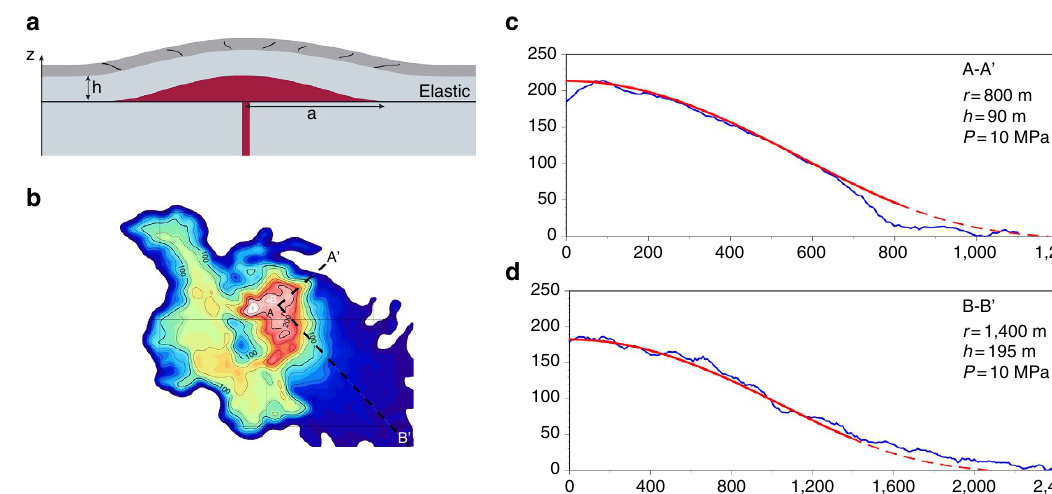
Figure 4 | Modeling deformation over a growing laccolith. ( a ) Model schematic showing a laccolith (red) and the overburden and wall rock in grey colours 23 . The overburden at Cordo ´ n Caulle is a mixture of dacite lava flows and pyroclastic fall deposits (Supplementary Fig. 3). ( b ) DTM difference map showing the positions of two surface profiles (A-A’ and B-B’) modelled with the deformation code of ref. 20. ( c ) Comparison of one, non-unique model solution (red) and natural topographic profile (that is, the land surface; blue) along the A-A’ section. The dashed parts of modelled profiles show the uplift occurring outside of the laccolith’s diameter. The model fit A-A’ ( R 2 ¼ 0.74) is compromised by the offset at the position of a growth fault in the natural section. The B-B’ profiles ( d ) are, however, nicely matched ( R 2 ¼